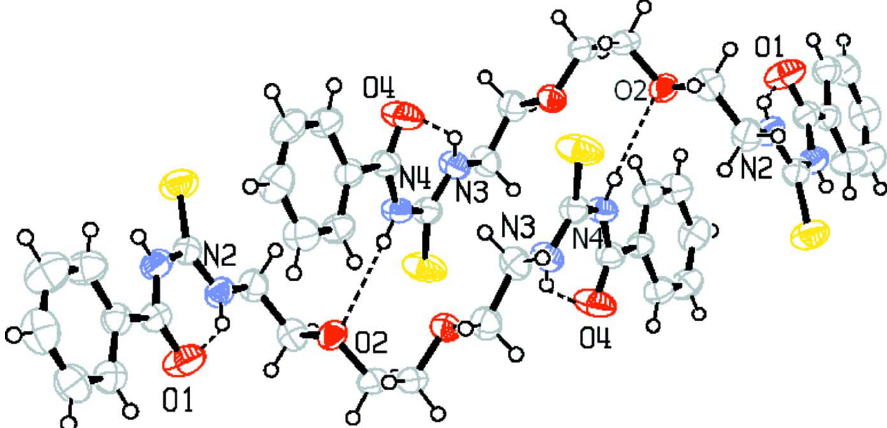
Figure 1 An ORTEP view of the asymmetric unit of the title compound, showing the atom-numbering scheme. Displacement ellipsoids are plotted at the 50% probability level.